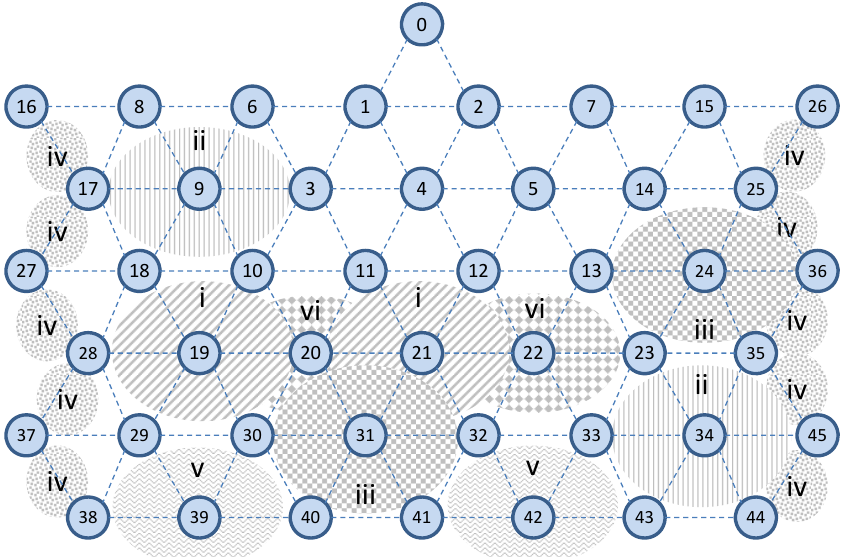
Figure 24. Applying interference incrementally in six